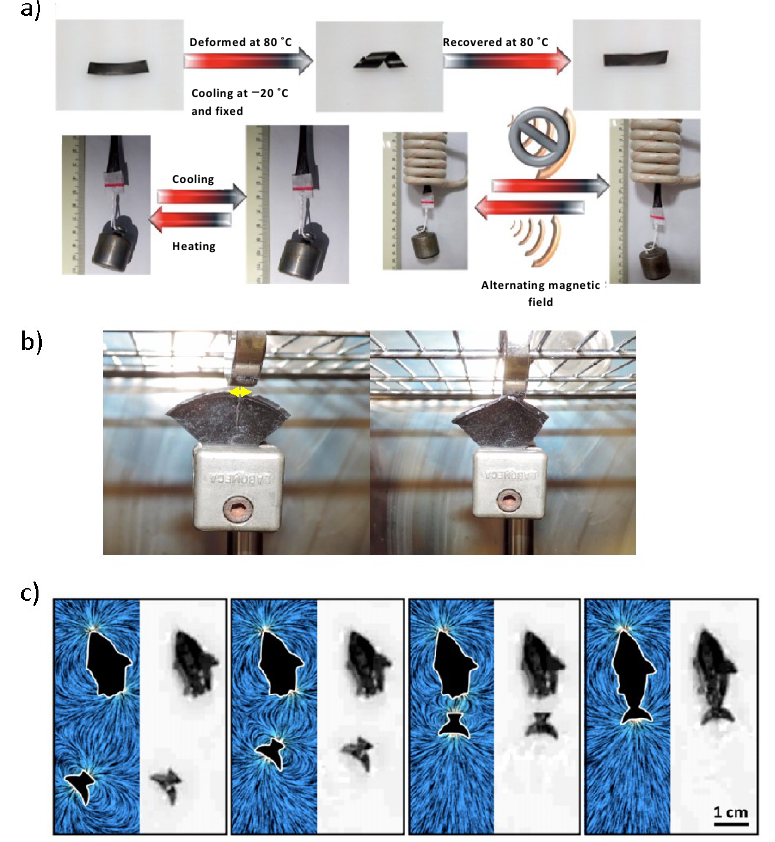
Figure 7. ( a ) Magnetic self-healing composite actuation using the shape-memory response under heating caused by a remote alternating magnetic field (adapted with permission from [51]. Copyright 2018, American Chemical Society); ( b ) magnetostriction-aided large damage healing (damage gap size of 4 mm–5 mm; adapted with permission from [56]. Copyright 2020, Elsevier; and ( c ) magnetic swimmer autonomously repaired “on-the-fly” using printed magnetic microparticles strips. Adapted with permission from [94]. Copyright 2021, American Chemical Society.